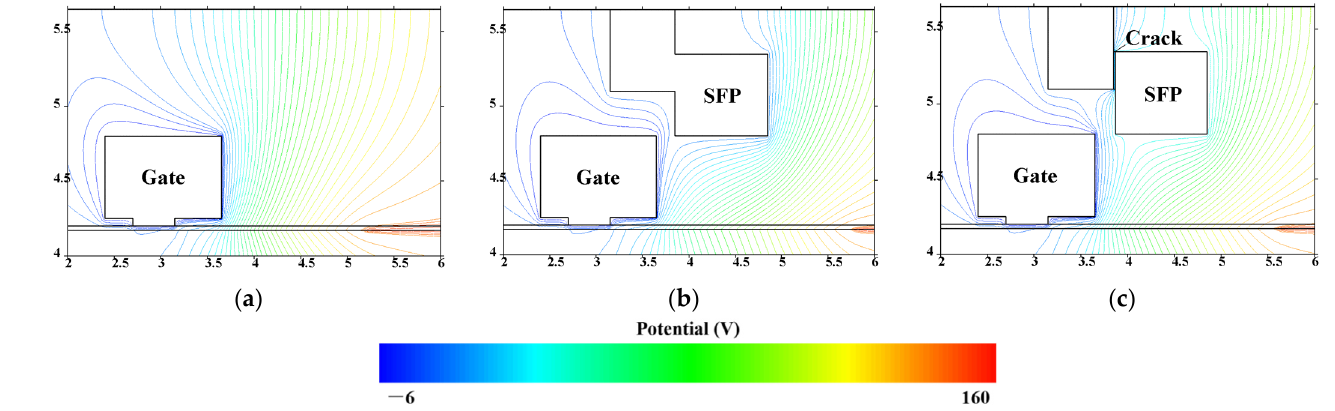
Figure 5. Potential contours for AlGaN/GaN HEMT ( a ) without an SFP; ( b ) with a conventional SFP; ( c ) with a 20 nm wide cracked SFP at V g = − 6 V, V d = 160 V. The electric field is also an important parameter which determines the V br of an HEMT device [28–30]. Therefore, the electric field along the channel before breakdown (V g = − 6 V, V d = 160 V) is shown in Figure 6. It was found that the electric field peaks all appeared at the gate edge of the drain side. The HEMT without an SFP showed the maximum electric field peak of 1.82 MV/cm. As the w increased, the electric field peak increased from 1.38 MV/cm to 1.70 MV/cm. It is obvious that the V br is inversely proportional to